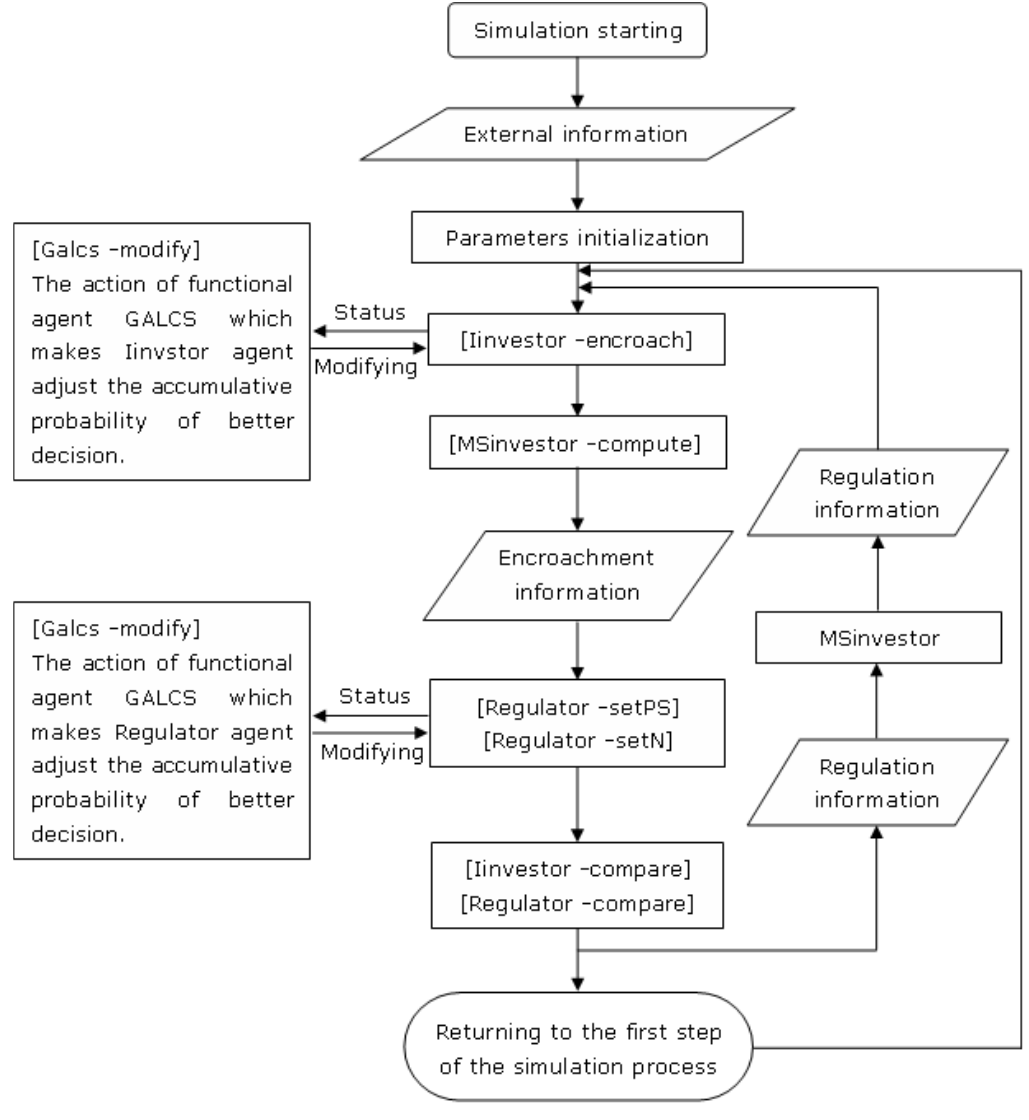
Figure 3. The process and information flows of the simulation